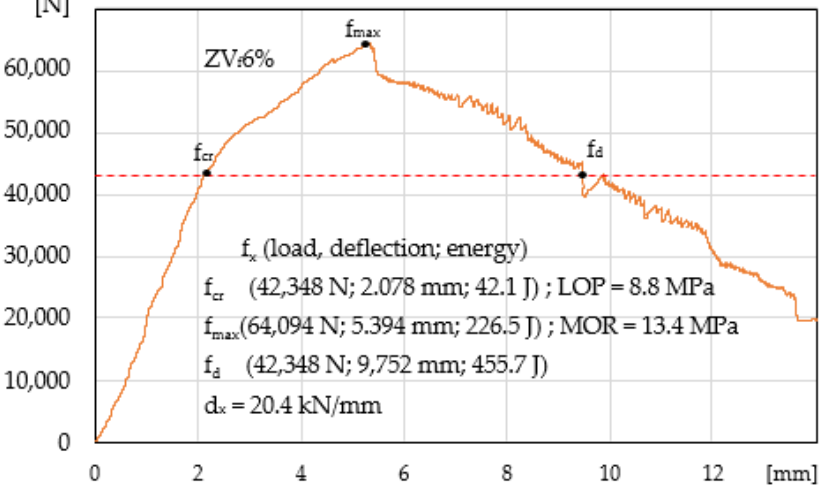
Figure 7. Load-deflection curve in the four-point bending test, paste ZV f 6%. The compilation of all the tested specimens (load-deflection curves) is presented in Figure 8. The curves illustrate the scale of obtained ESD effects as compared with the ma-